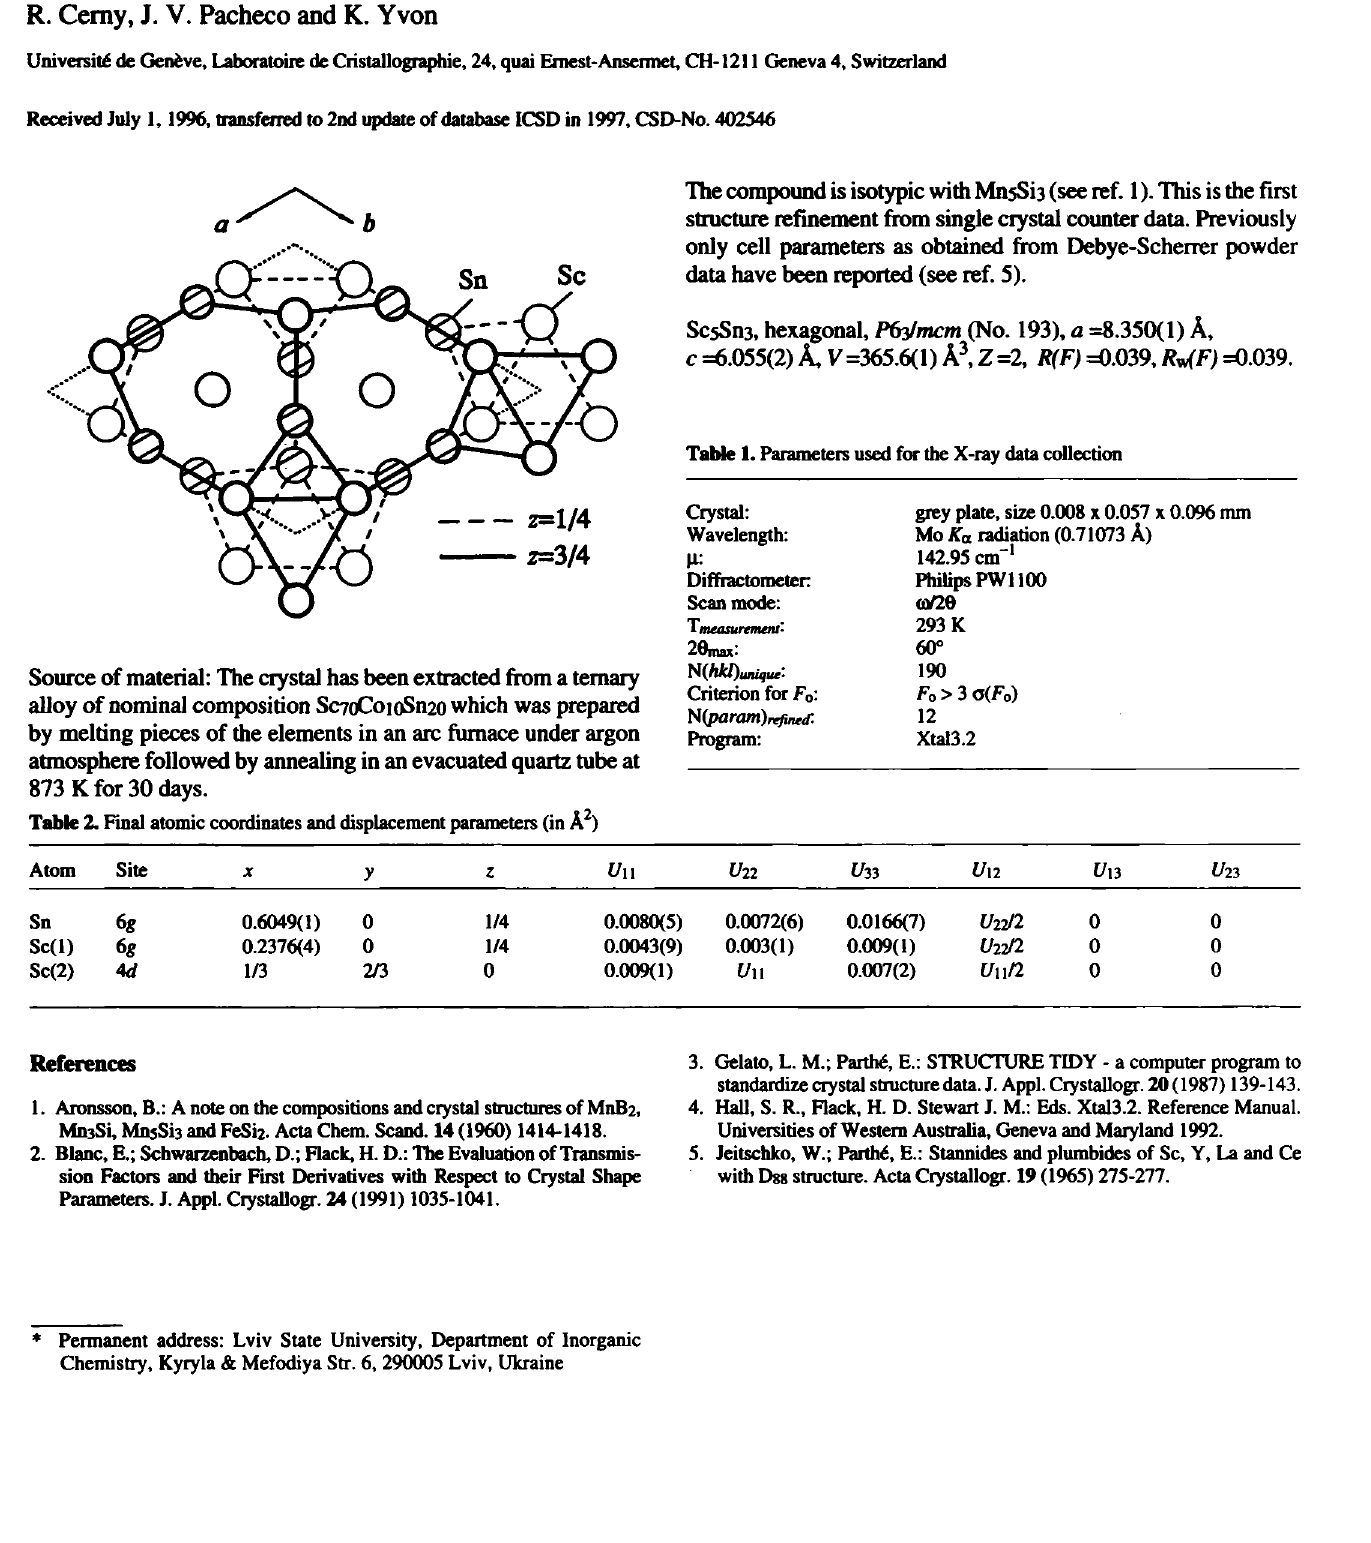
data have been reported (see ref. 5).